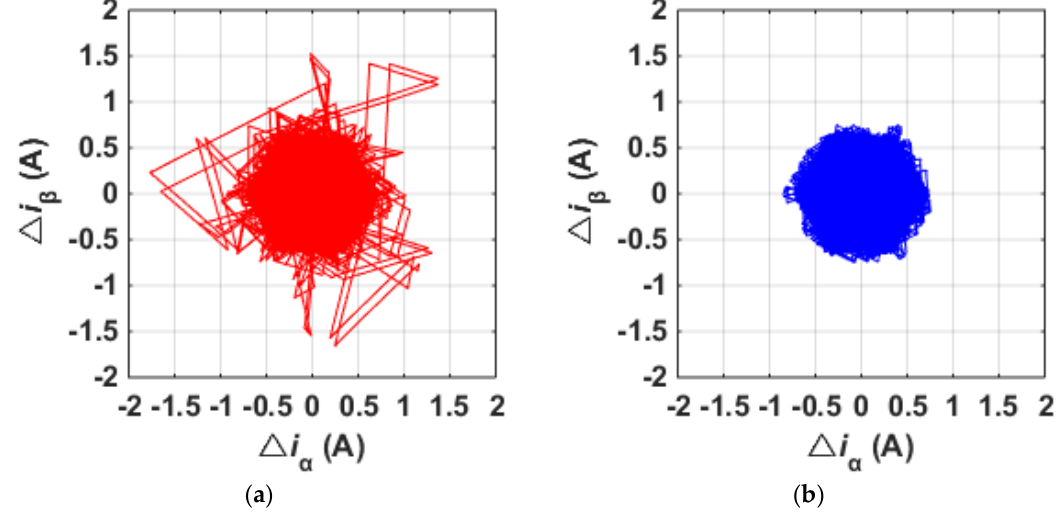
Figure 18. The vectorgraph of the current error. ( a ) S-FHCC; ( b ) ST-FHCC .